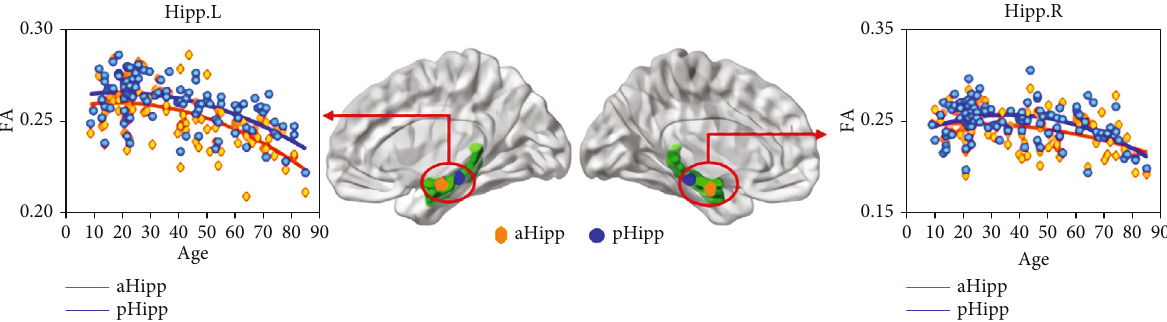
Figure 2: Trends of hippocampus white matter structural FA with age. The inverted U-shaped trajectories of FA included aHipp.L, pHipp.L, and pHipp.R. Orange plots represented the aHipp and blue plots the pHipp.